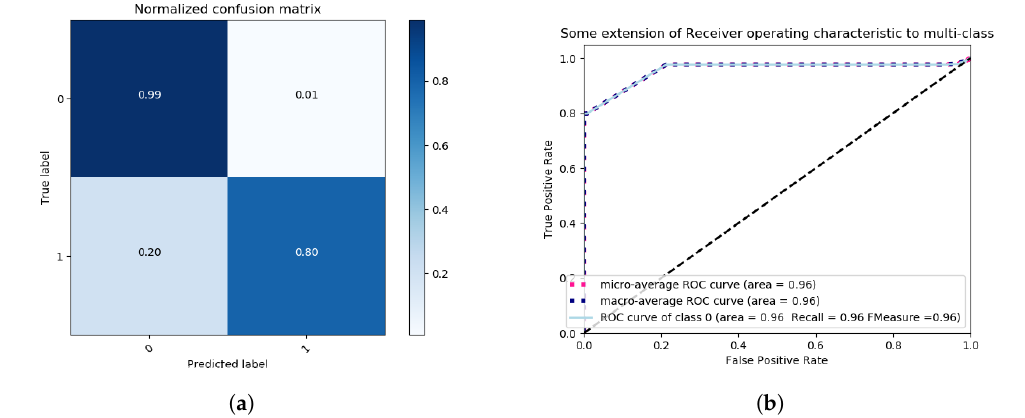
Figure 10. Binary class problem—Grid Search SVM with sigmoidal Kernel, One vs. Rest decision function shape, 30 iterations, and a scoring criterion of accuracy confusion matrix ( a ) and ROC Curves ( b